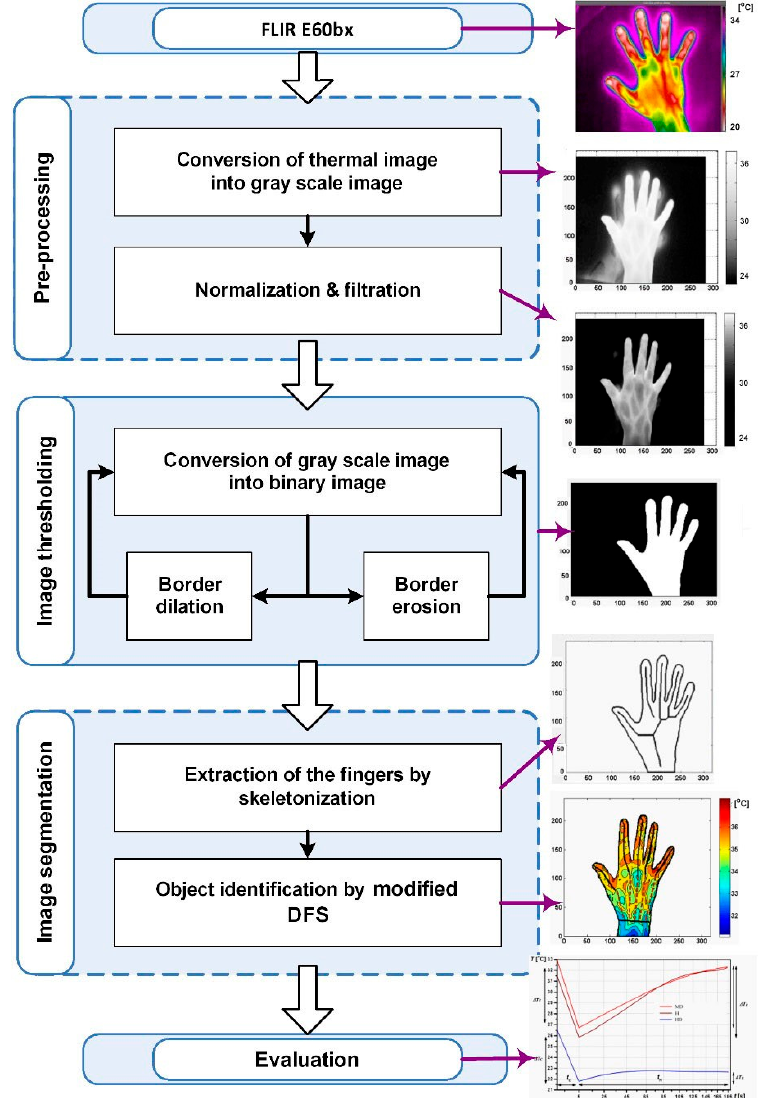
Figure 3. Workflow of thermographic image processing.